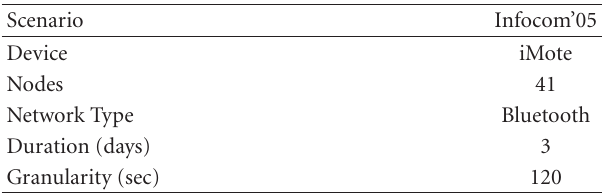
Table 1: The real Infocom’05 scenario analyzed in